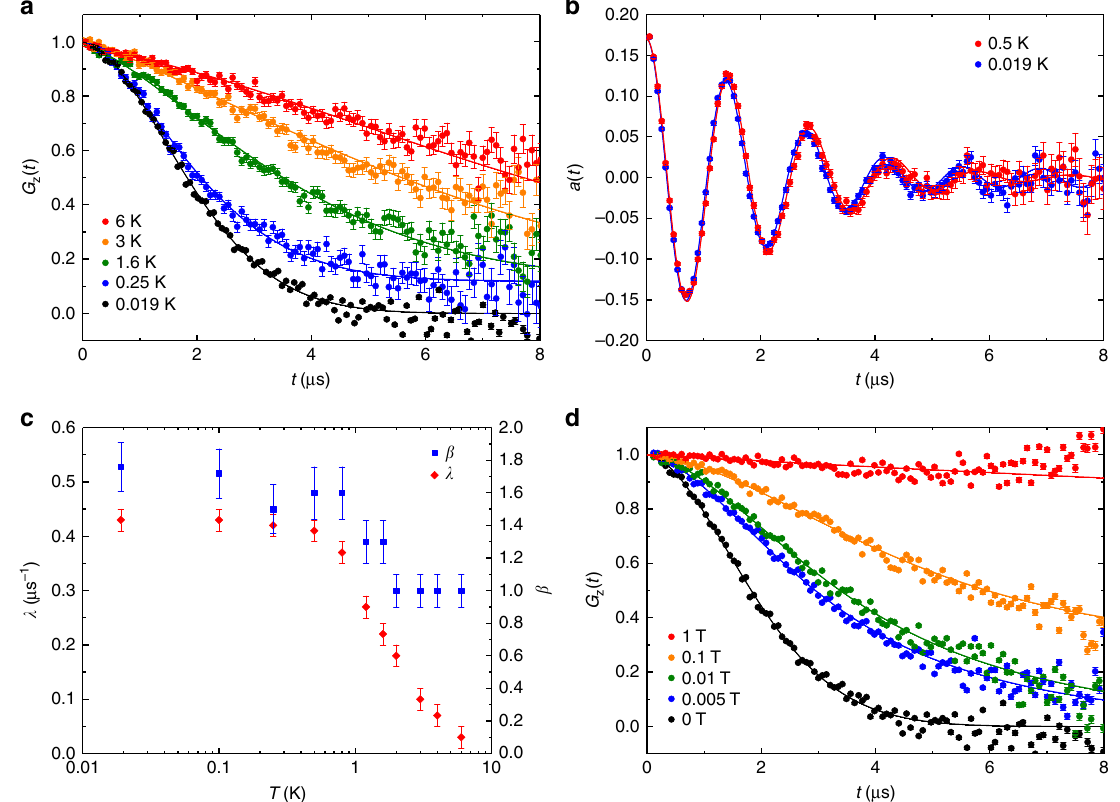
Fig. 4 μ SR measurements of Sr 2 Cu(Te 0.5 W 0.5 )O 6 . a Zero- fi eld muon spin relaxation function G z ( t ) measured at different temperatures. b Muon spin rotation spectra a ( t ) measured with a 5 mT transverse- fi eld at 19 mK and 0.5 K. c Muon spin relaxation rate λ and power β as a function of temperature from fi ts of the zero- fi eld data using exp(-( λ t ) β ) as the depolarization function. d Longitudinal- fi eld muon spin relaxation function G z ( t ) at 19 mK measured with different applied longitudinal fi elds. The error bars in a , b and d represent 1 s.d. and in ( c ) the maximum possible variation due to correlation